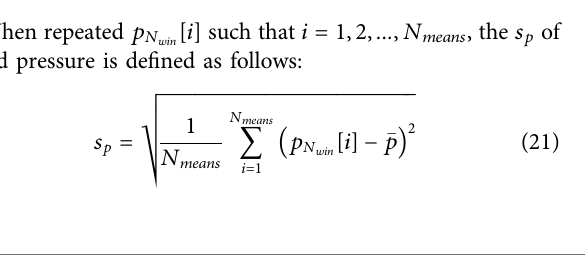
FIGURE 11 | Schematic diagram of rotating radial rakes in experimental